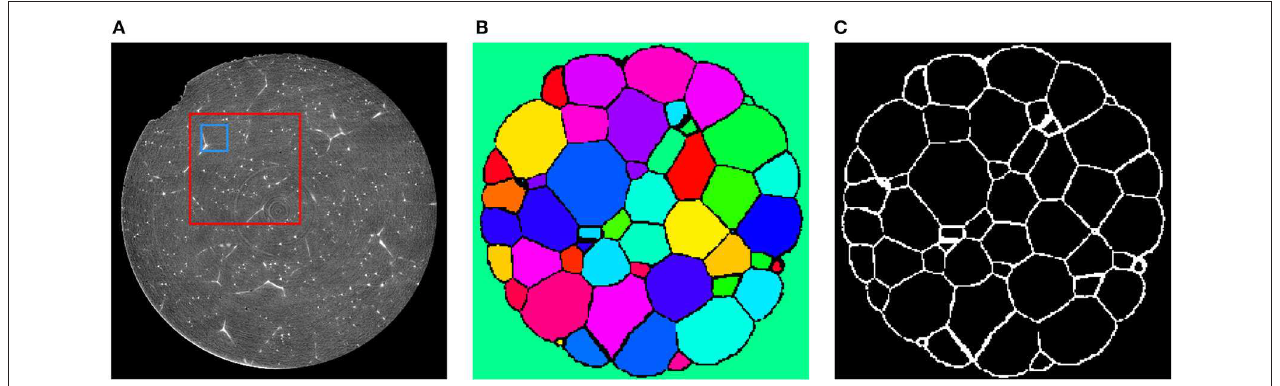
FIGURE 6 | (A) Cross-section of C 2 depicting the sample after 20 min of Ostwald ripening. These images will be used as training input for the CNN. The blue square indicates the size of an 80 × 80 cutout with respect to the original resolution of the CT data. After downsampling the data to the resolution of 240 × 240 × 420 voxels an 80 × 80 cutout has the relative size indicated by the red square. (B) Segmentation of the corresponding section obtained via 3DXRD microscopy. (C) Cross-section of the extracted grain boundary image L 2 from the 3DXRD data. The grain boundary images L t will be used as target images for the input images C t during training of the CNN.